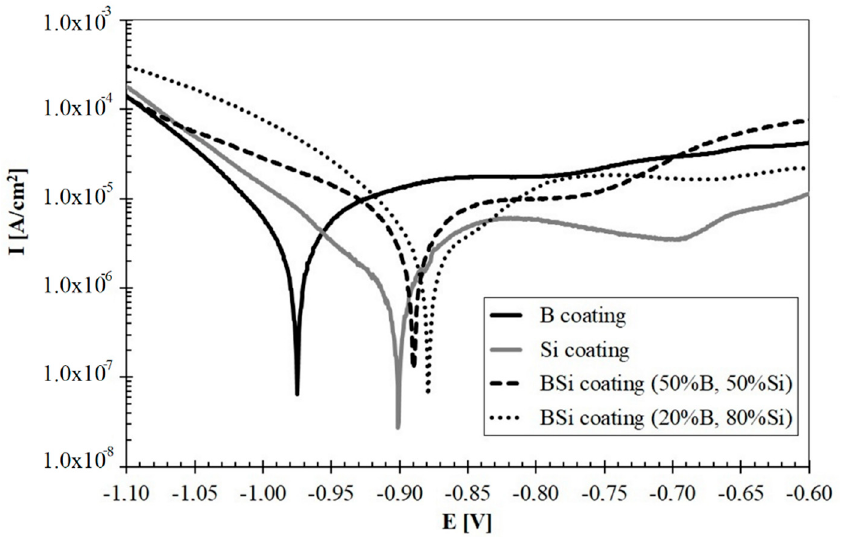
Figure 12. Corrosion resistance of studied B, Si and B-Si coatings.